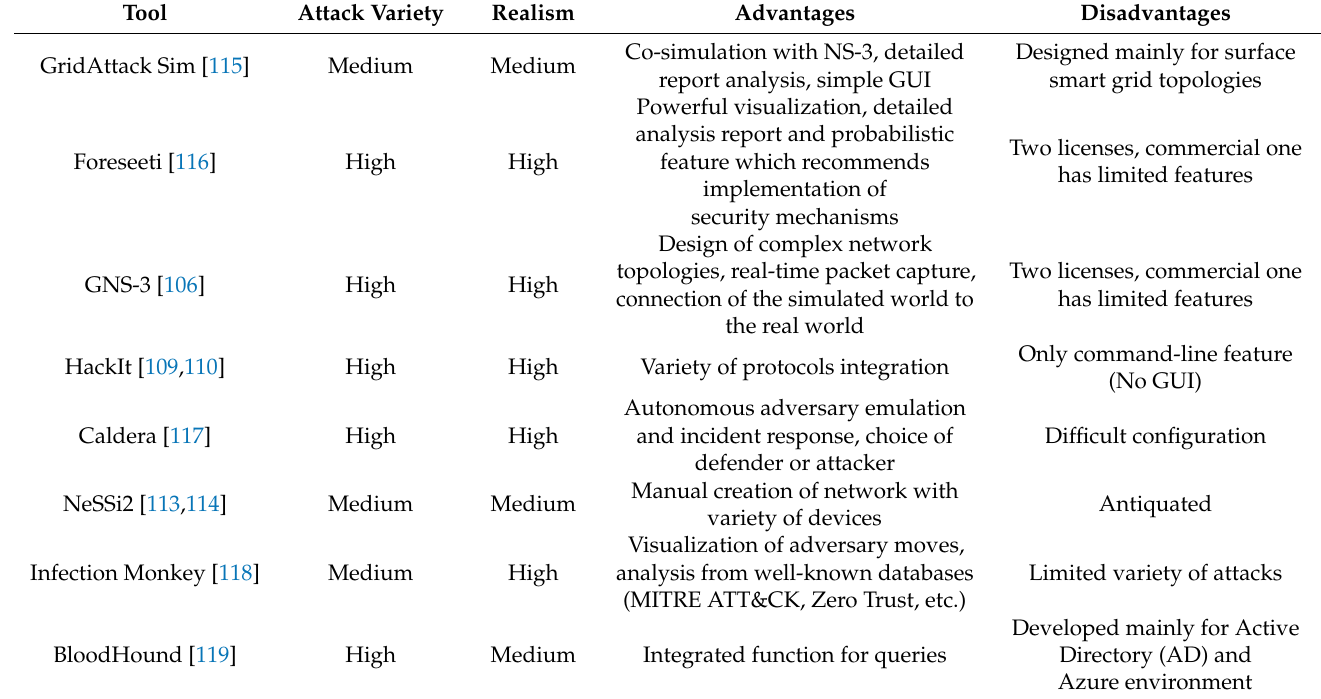
Table 5. Comparison of security simulation